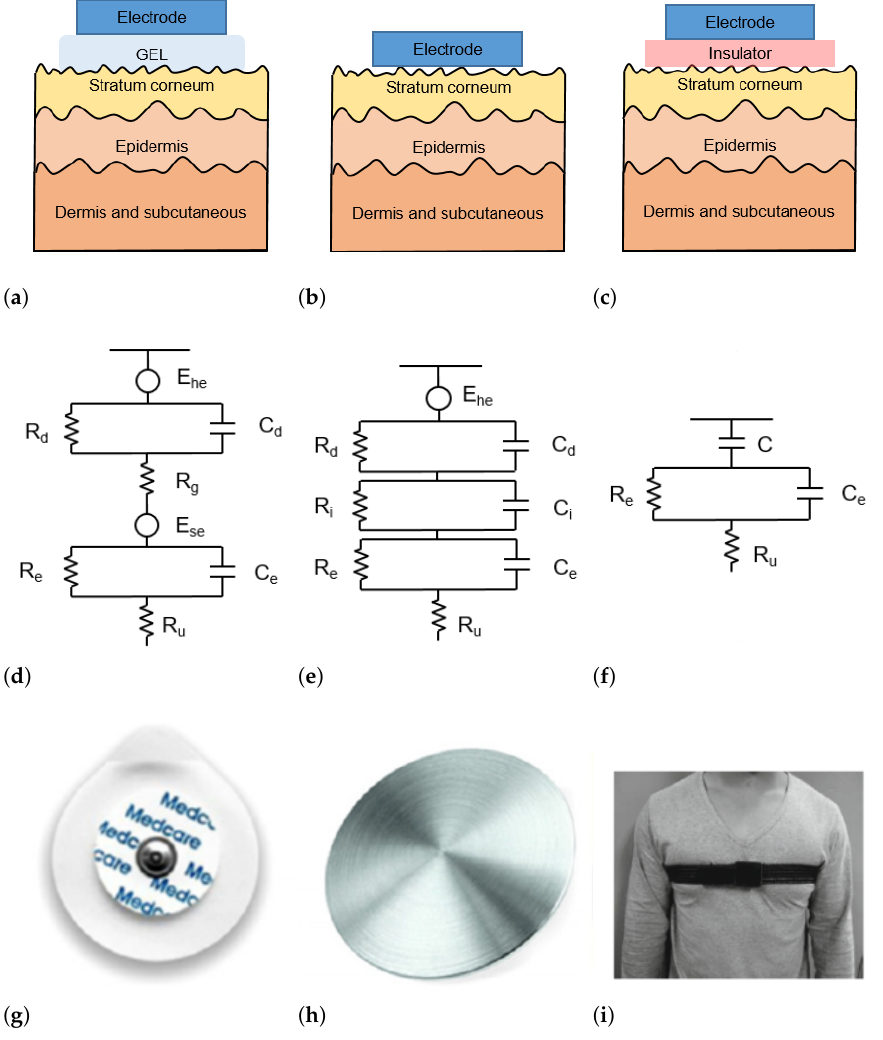
Figure 2. ( a – c ) Schematic representation of skin-electrode interface for wet ( a ), dry ( b ), and capacitive ( c ) electrodes; ( d – f ) equivalent circuit model of skin–electrode interface for wet ( d ), dry ( e ), and capacitive ( f ) electrodes; ( g – i ) example of wet ( g ), dry ( h ), and capacitive ( i )